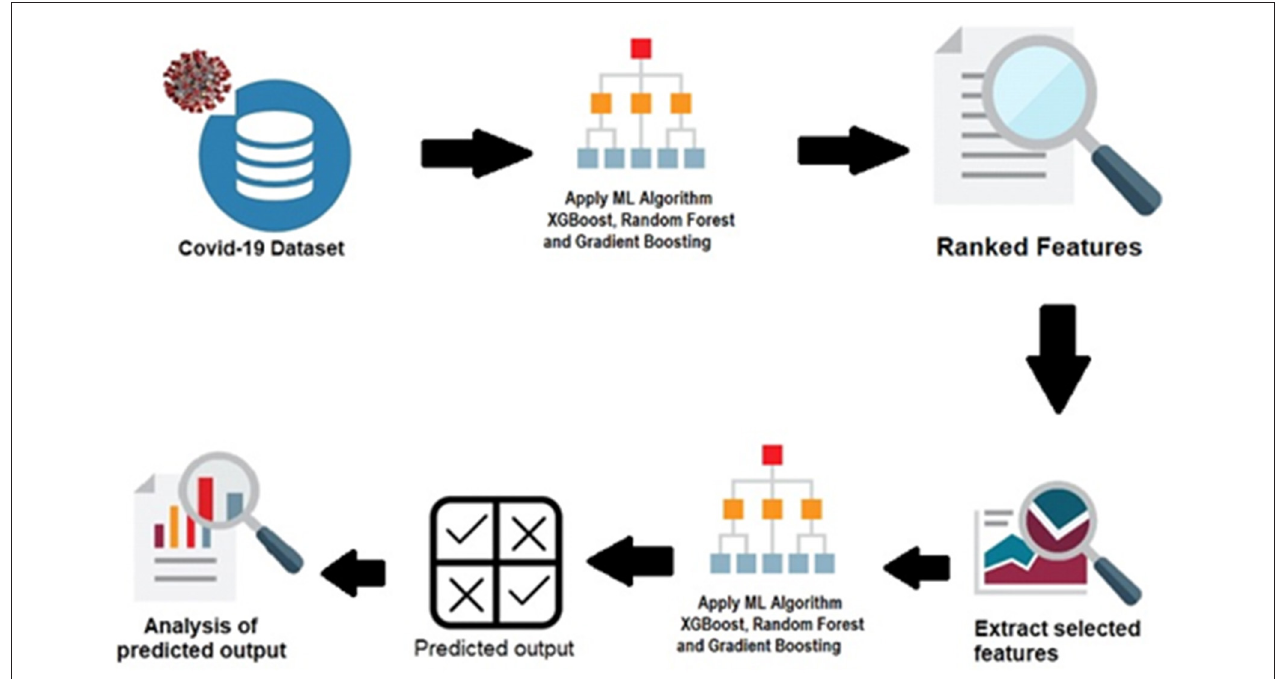
FIGURE 1 | Proposed system